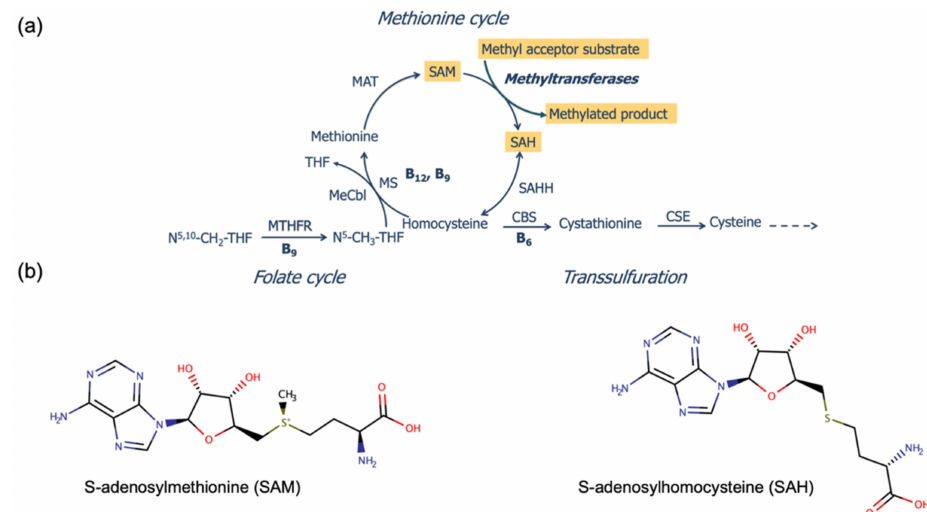
Figure 1. Metabolic pathways and structure of SAM and SAH. ( a ) All SAM and SAH derive from the methionine cycle, which relies on the availability of the water-soluble vitamins B 6 (pyridoxal phosphate), B 9 (folate), and B 12 (cobalamin) that serve as enzyme cofactors. The methylation of methionine by methionine adenosyl transferase (MAT) produces SAM. In reactions catalysed by methyltransferases, SAM transfers methyl groups to a variety of acceptors that include nucleic acids, proteins, and neurotransmitter precursors. The demethylation of SAM yields SAH, which undergoes reversible conversion to homocysteine by SAH hydrolase (SAHH). Homocysteine can undergo remethylation via methionine synthase (MS), an enzyme that utilises both B 9 (specifically, N 5 -methyltetrahydrofolate, synthesised by 5,10-methylentetrahydrofolate reductase, MTHFR) and B 12 as cofactors, or by entering the transsulfuration pathway to produce cystathionine for down- stream glutathione biosynthesis in a reaction catalysed by B 6 -dependent cystathionine β -synthase (CBS). ( b ) The structure of SAM and SAH. The strong electrophilic property of the sulfur-linked methyl group in SAM is exploited by methyltransferases to facilitate the methylation of a variety of nucleophile-containing substrates, thereby forming SAH as a product. While methyl group transfer is the most-studied group donation, SAM is also a source of other groups, such as amino, aminoalkyl, and ribosyl moieties